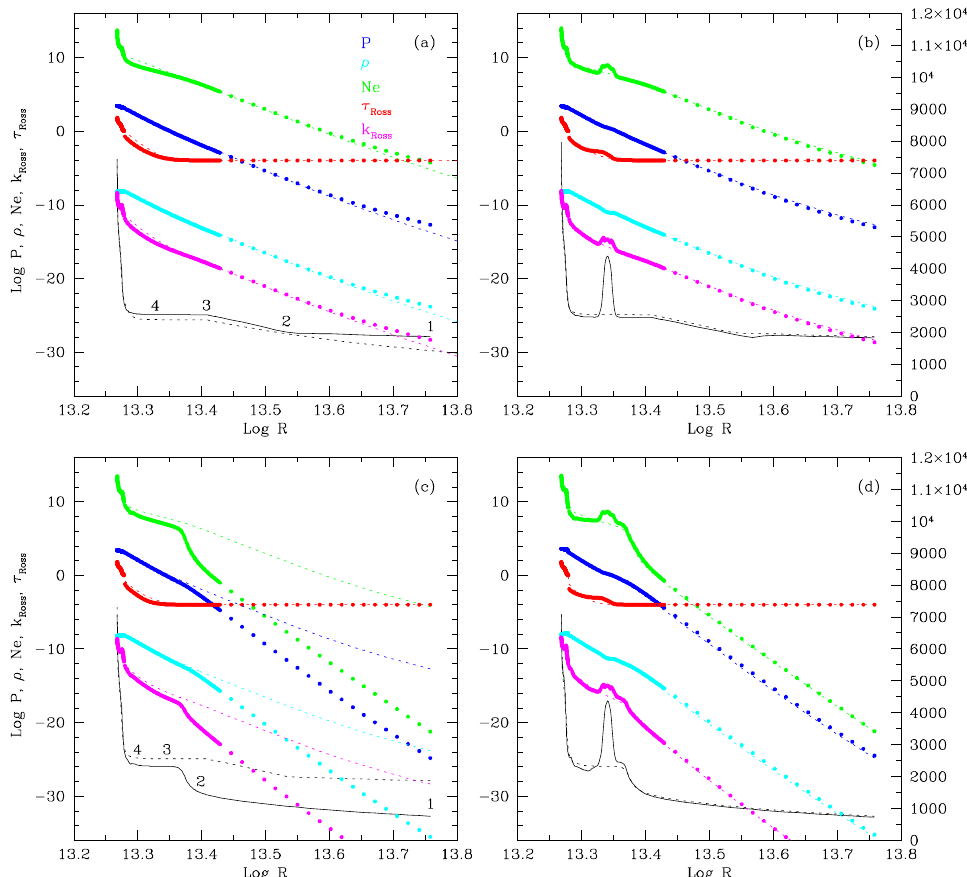
Figure 2. The dependence on the radial distance R of the temperature T (black), pressure P (blue), density ρ (cyan), nr. of electrons per cubic centimeter N e (green), Rosseland mean opacity k Ross (magenta) and Rosseland optical depth τ Ross (red). The dotted lines correspond to the input model of each run of iterations. The left panels refer to solutions in radiative equilibrium: ( a ) without molecules, compared with the relevant gray model; ( c ) with molecules, compared with the solution ( a ). The right panels show the same when an amount of non-radiative energy equal to 0.025 erg · cm − 3 is injected at Log R = 13.34: ( b ) without molecules, compared with the solution ( a ); ( d ) with molecules, compared with the solution ( c